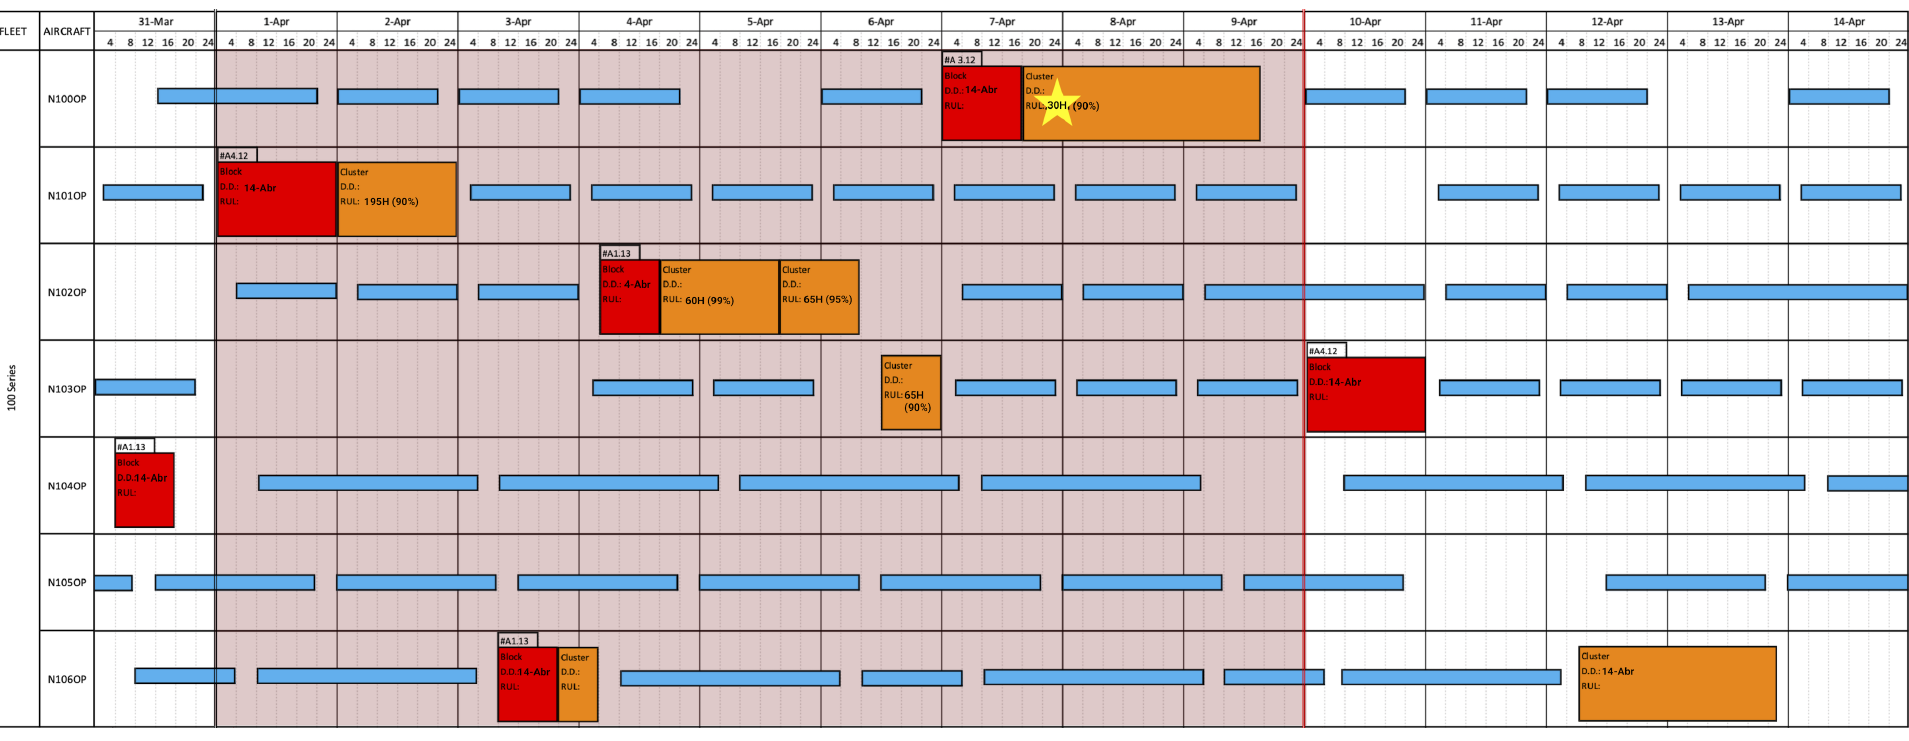
Figure 2. Maintenance scheduling problem presented to the participants in the experimental session. Flights : blue rectangles; Blocks: red rectangles; Clusters: orange rectangles; Star: the yellow star inside Cluster represent a new maintenance problem presenting a restrictive